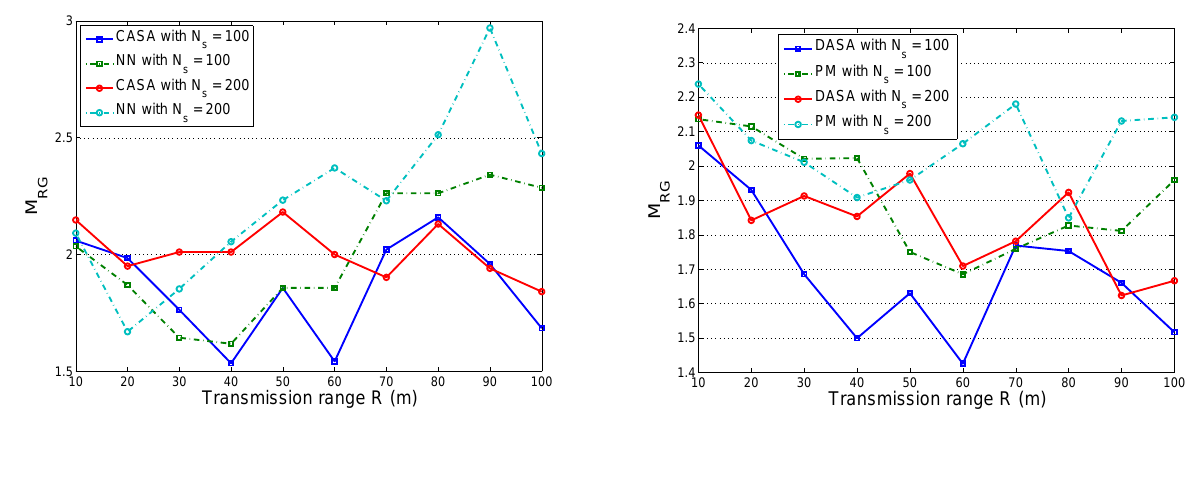
Figure 17. The number of active nodes in a round M R